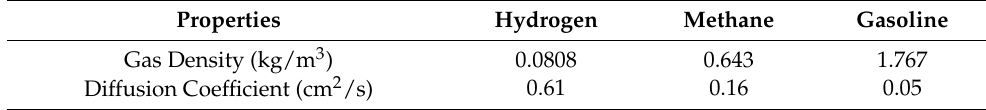
Table 1. Properties of hydrogen, methane, and gasoline